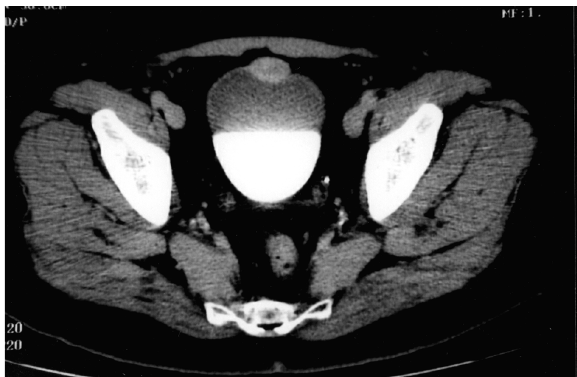
Figure 2 – Computed tomography demonstrating a midline in- tramural leiomyoma at the bladder